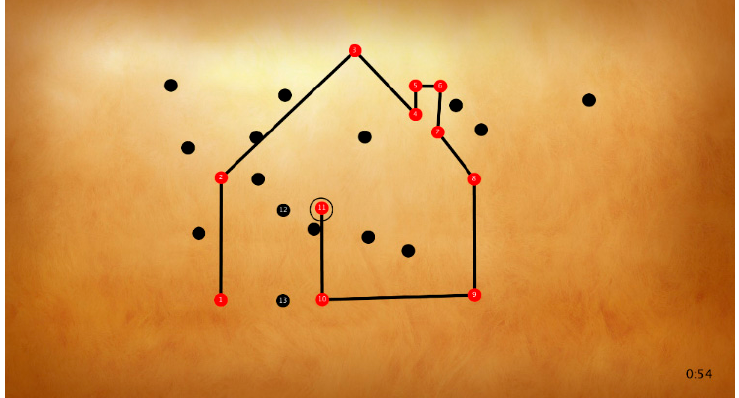
Figure 4. “Connect the dots” main panel.